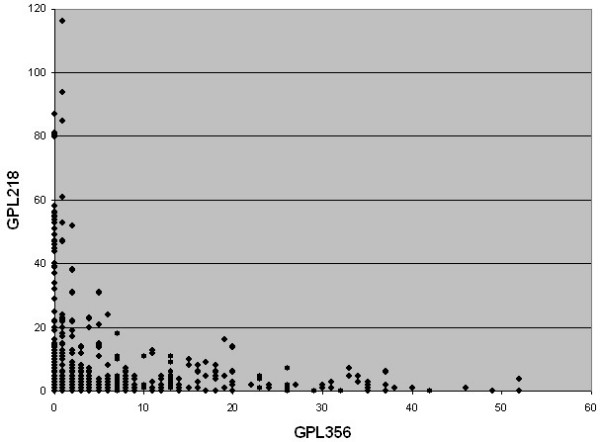
Correlation in significant terms between data sets. The number of times each term was observed as significant based on the analysis of two different sets of Drosophila genes are scatter plotted.